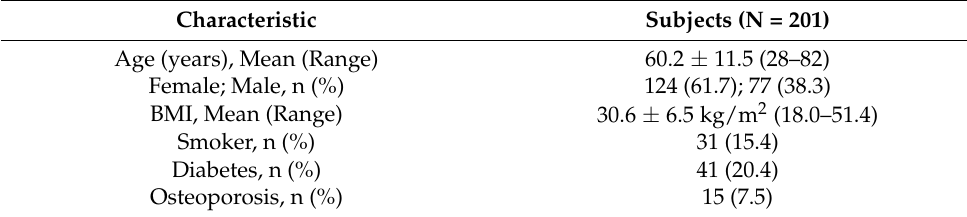
Table 1. Baseline Demographics and Clinical